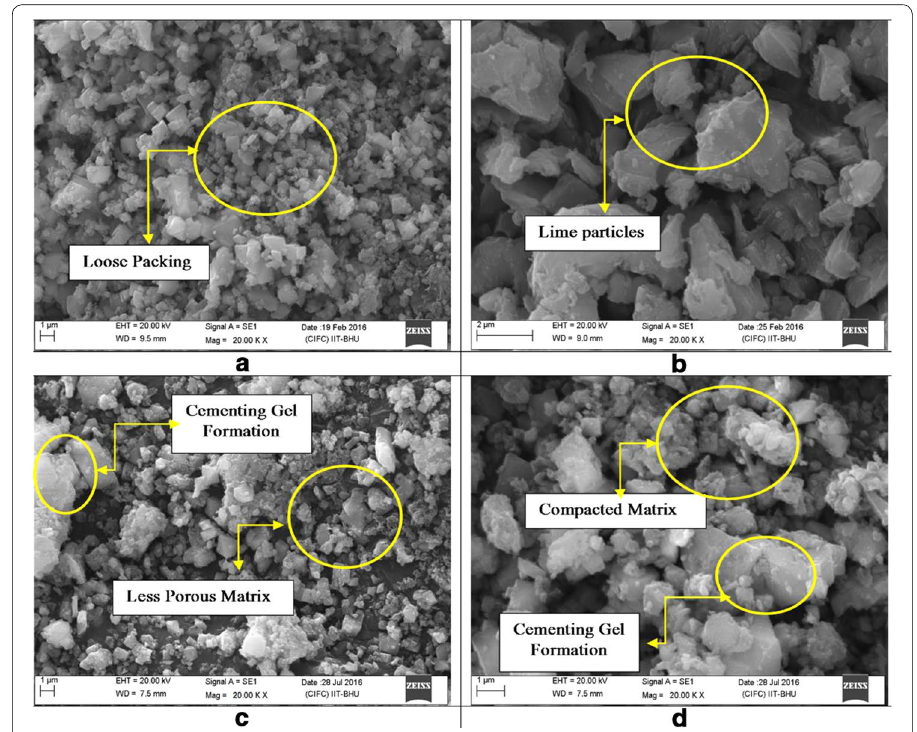
Fig. 9 SEM images (Magnification 20 kx) of jarosite-lime blends a jarosite; b lime; c jarosite-lime blend (5% = lime and 90 days curing); d jarosite-lime blend (10% lime and 90 days